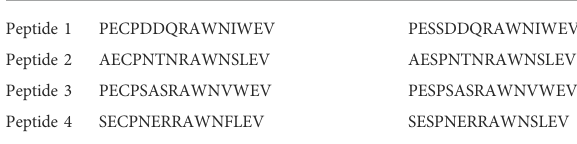
TABLE 1 Amino acid sequences of native proteins vs . the changes made to the amino acid sequence during peptide designing. Original amino acid